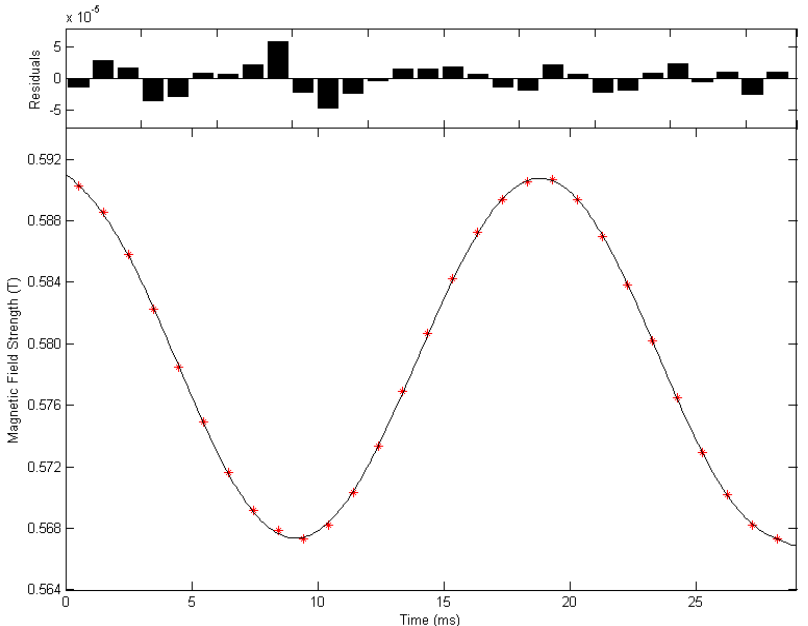
Figure 11. Fitting curve of the alternating magnetic field when the operating voltage is 250 V and residual error.